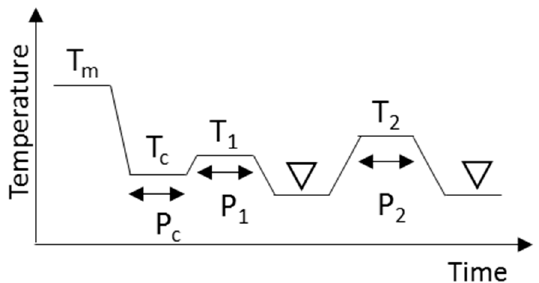
Figure 9. Schematic drawing of the crystallization and heat treatment conditions needed to obtain β forms. Triangles indicate the regions where XRD and DSC measurements were made at 20 °C. Tm, Tc, T 1 , and T 2 are temperatures and Pc, P 1 , and P 2 are time periods. Table 3. Heat treatment conditions for producing multiple β forms of TAG.